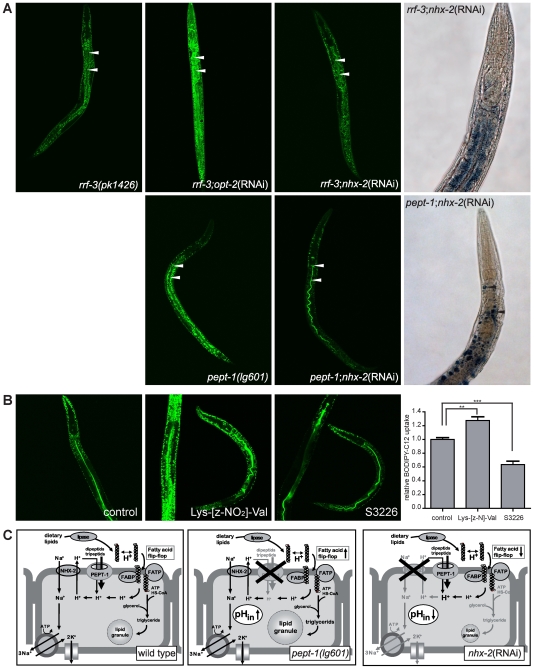
Increased uptake of free fatty acids induces the obesity phenotype in pept-1(lg601).(A) Uptake of free fatty acid BODIPY-C12 in rrf-3(pk1426), rrf-3;pept-1(RNAi), rrf-3;nhx-2(RNAi), pept-1(lg601) and pept-1;nhx-2(RNAi) C. elegans. Left panel, pept-1(lg601) and rrf-3;pept-1(RNAi) show a higher uptake of BODIPY-C12 fatty acid indicated by a stronger green fluorescent signal in the cellular fat granules, while nhx-2 RNAi significantly decreased the uptake of the free fatty acid in rrf-3 and pept-1 C. elegans. A FITC filter was used to visalize BODIPY fluorescence. Arrows indicate the intestinal lumen. Right panel, Body fat content in rrf-3;nhx-2(RNAi) and pept-1;nhx-2(RNAi) C. elegans. nhx-2 RNAi treatment reduced the body fat in rrf-3 and pept-1 worms (compare to Fig. 1A). Body fat was visualized by Sudan Black staining. Arrows indicate single fat granules. (B) Wild type C. elegans incubated for one hour in control (M9 buffer containing 0.1% DMSO), 1 mM of the PEPT antagonist Lys-[z-NO2]-Val or 1 µM of the NHE3 inhibitor S3226 before BODIPY-C12 free fatty acid uptake. Inhibition of the peptide transporter increases the fatty acid uptake while inhibition of the sodium/proton exchanger reduces fatty acid uptake. The diagram summarizes the relative fluorescent signal intensity, which is directly proportional to the BODIPY-C12 uptake, in the head and anterior intestine of 15–20 individual worms per group. **: p = 0.01, ***: p≤0.001. (C) Proposed model for the uptake of fatty acids into the intestinal epithelial cells of wild type, pept-1(lg601) and nhx-2 RNAi treated C. elegans. Left panel, In the intestinal epithelial cells of wild type the PEPT-1-driven proton influx is neutralized by the action of the Na+/H+ exchanger NHX-2, inducing a neutral intracellular pH. The flip-flop of free fatty acids is happening at a low rate. Middle panel, When the peptide transporter is eliminated, the influx of protons is reduced leading to an increased pHin. The flip-flop of protonated fatty acids is enhanced and increase desorption of fatty acids into the cell. Higher amounts of triglycerids are formed that are stored in large lipid granules. Right panel, The reduced expression of nhx-2 leads to a PEPT-1-driven slight acidification of the intestinal cells which reduces the flip-flop and therefore the uptake of fatty acids and finally lead to a lean phenotype. FABP fatty acid binding protein, FATP fatty acid transport protein.